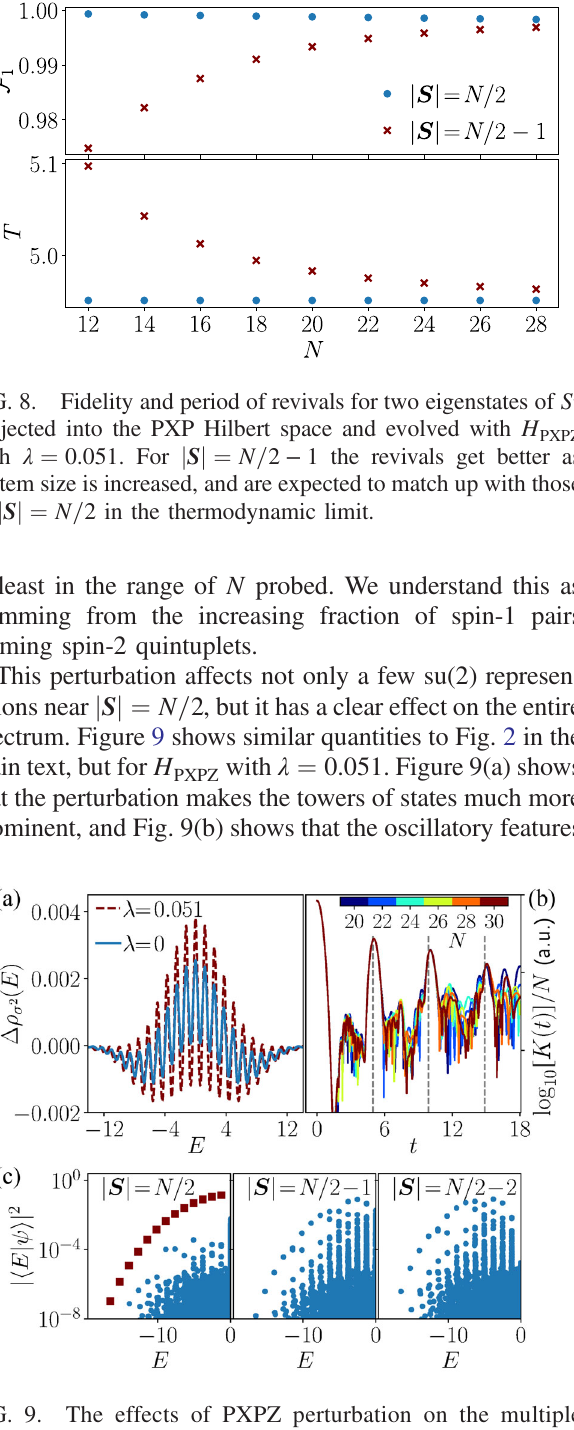
FIG. 9. The effects of PXPZ perturbation on the multiple su(2) representations. (a) Difference between the SDOS with and without the perturbation. (b) The peaks in the SFF are converged for various system sizes and occur at roughly the same times as the quench revivals from the N´eel state, indicated by the dashed lines. (c) Overlap between eigenstates of S z and the eigenstates of the perturbed PXP model. The red squares indicate the usual scarred eigenstates with high overlap with the N´eel state. The data in panels (a) and (b) was obtained with N ¼ 28 .